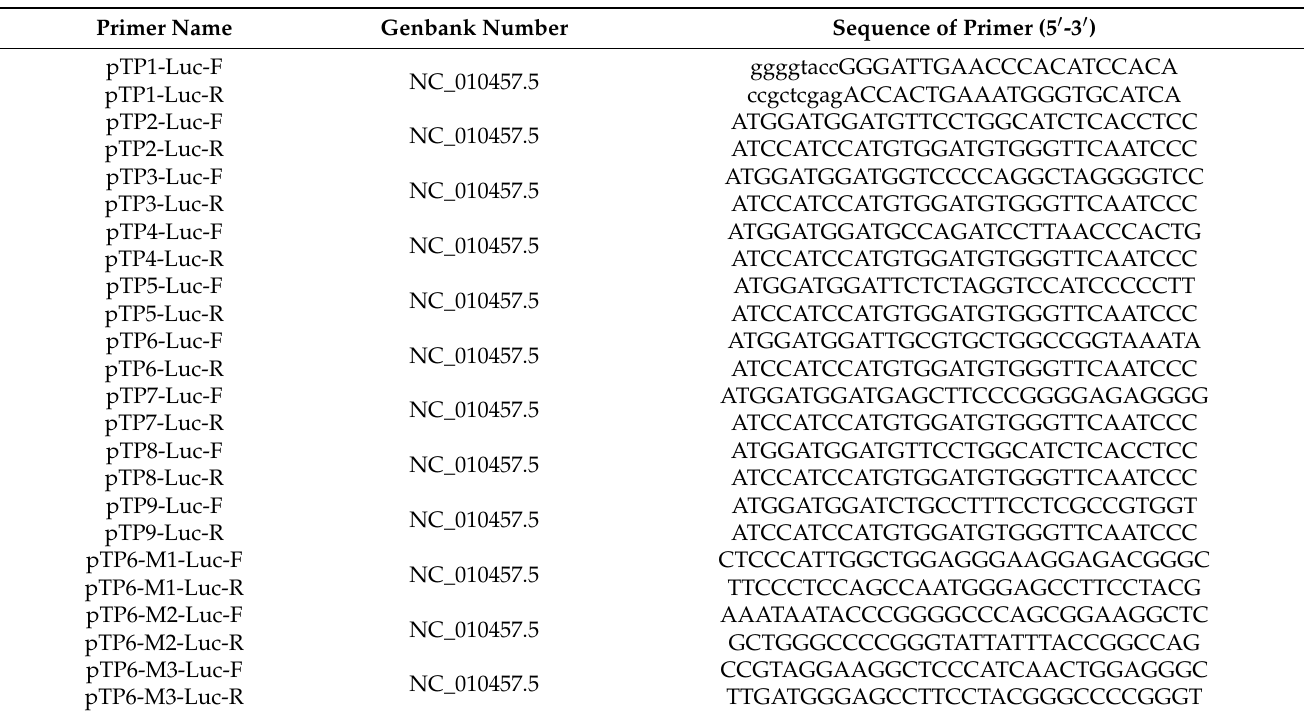
Table 3. The primers used for Luciferase reporter